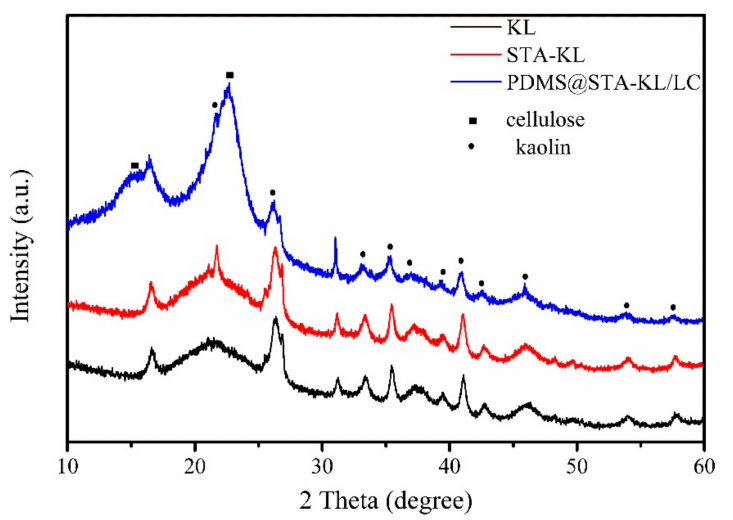
Figure 4. X-ray diffraction patterns of KL, STA-KL and LC coated with